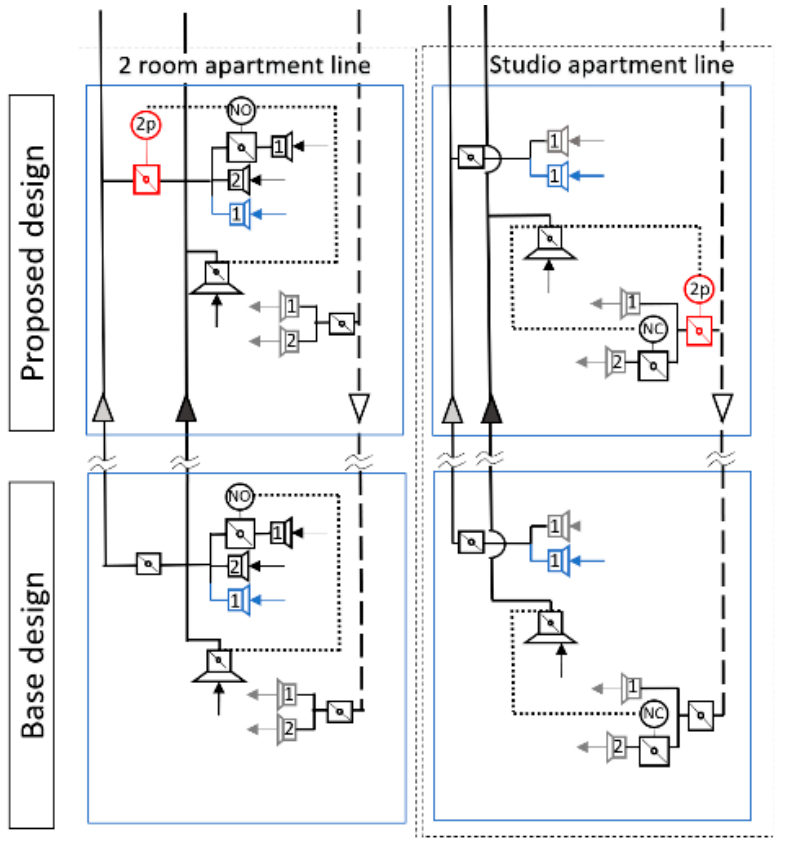
Figure 6. Apartment airflow rate control schemes in the standard design and proposed improved concept.